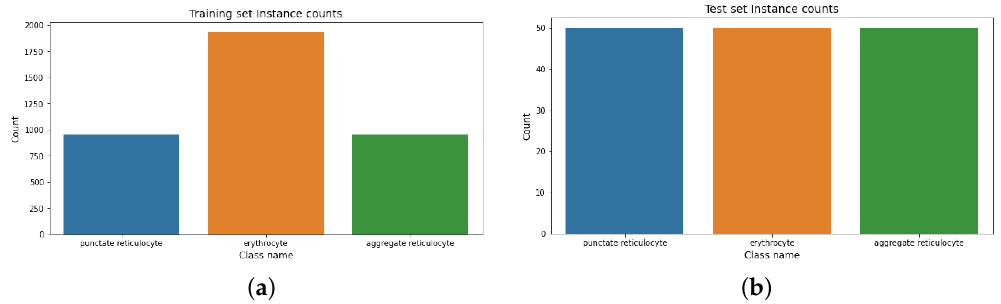
Figure 6. Instances count for the feline reticulocyte dataset. ( a ) Training instance count for the feline reticulocyte dataset. ( b ) Test instance count for the feline reticulocyte